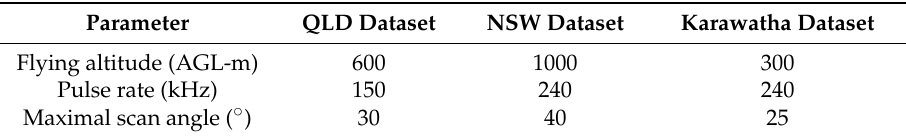
Table 1. Data specification.